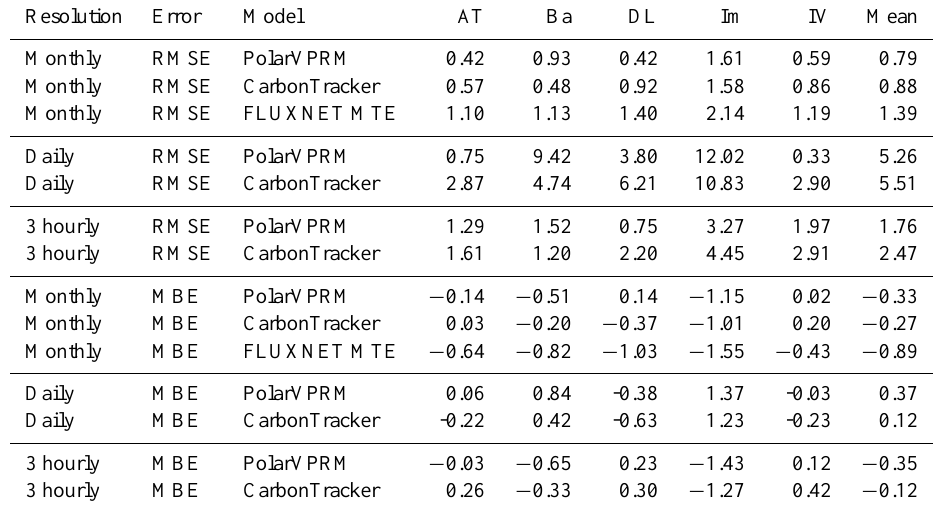
Table 5. Error statistics (RMSE and MBE; in µmol CO 2 m − 2 s − 1 ) found through the comparison of monthly, daily and 3-hourly averaged estimates of NEE from PolarVPRM, CarbonTracker and FLUXNET model tree ensemble relative to observations of 3-hourly, daily and monthly averages of NEE from Atqasuk (AT), Barrow (Ba), Daring Lake (DL), Imnavait (Im) and Ivotuk (IV). Resolution Error Model